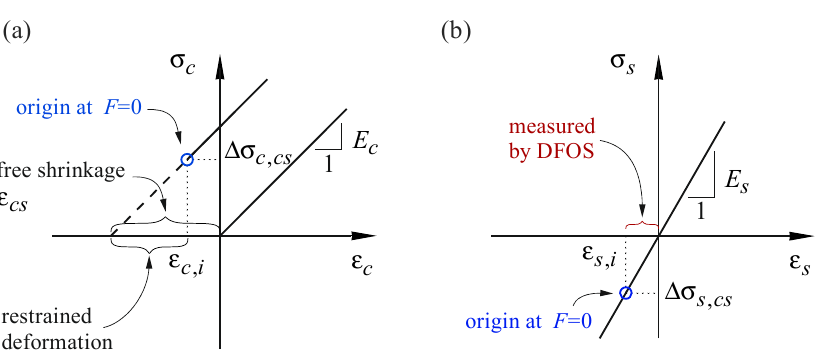
Figure 7. Schematic representation of shrinkage-induced strain and stress in ( a ) concrete and ( b ) reinforcing bar.